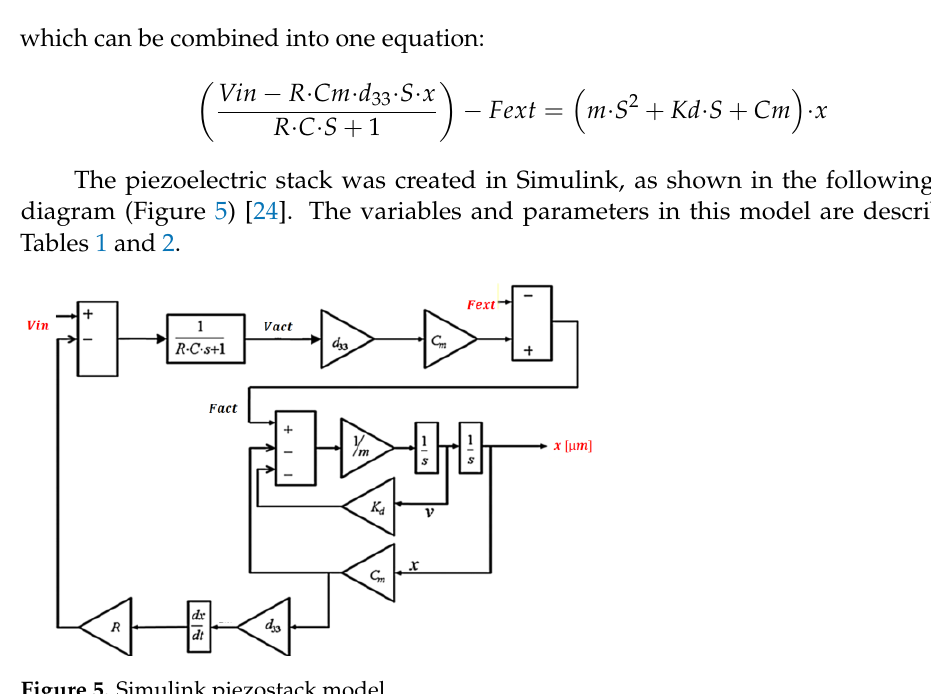
Figure 5. Simulink piezostack model. Table 1. Model variables.